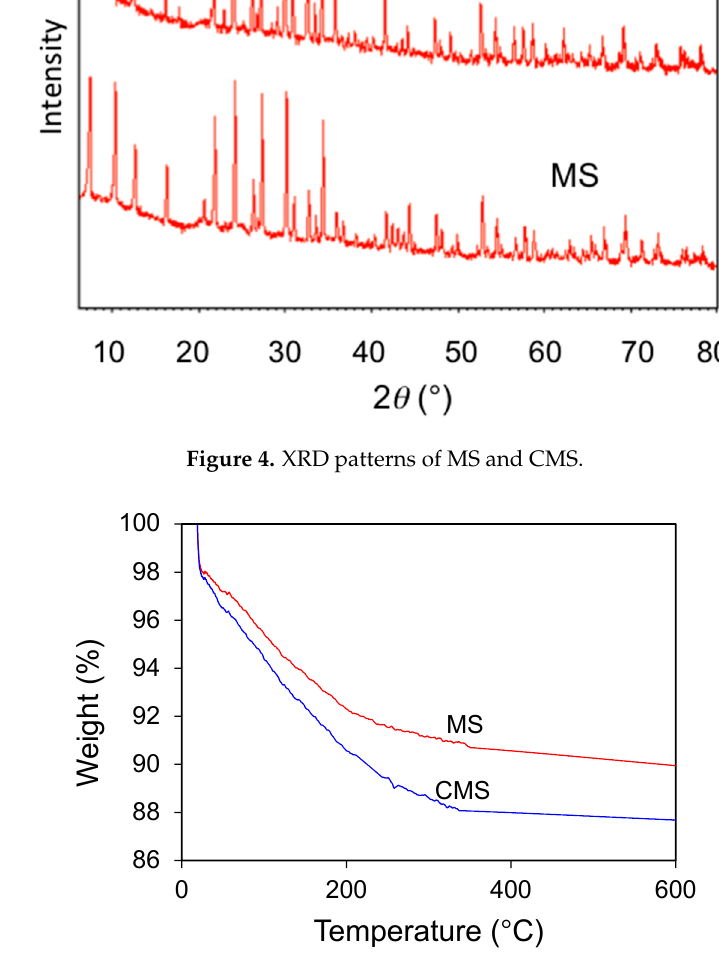
Figure 5. Thermogravimetric analysis of MS and CMS.